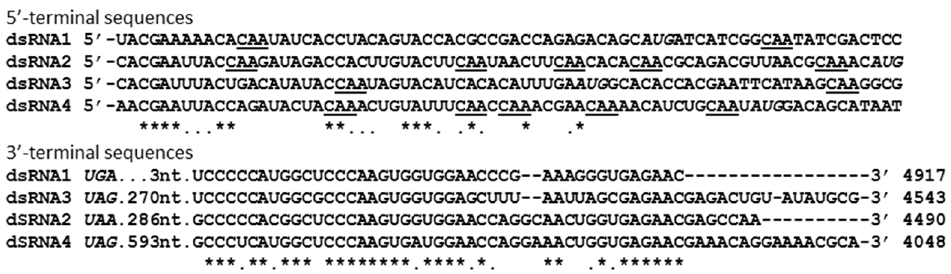
LR028031 Figure 3. Terminal sequence domains of the LbQV-1 genome. Sequences of the 5’- ( A ) and 3’-termini ( B ). Identical sequences are denoted by asterisks and sequences present in ¾ dsRNAs are shown as dots. CAA repeats in the 5’terminal region are underlined and the possible initiation AUG codons and termination codons UGA, UAA and UAG are shown in italics.